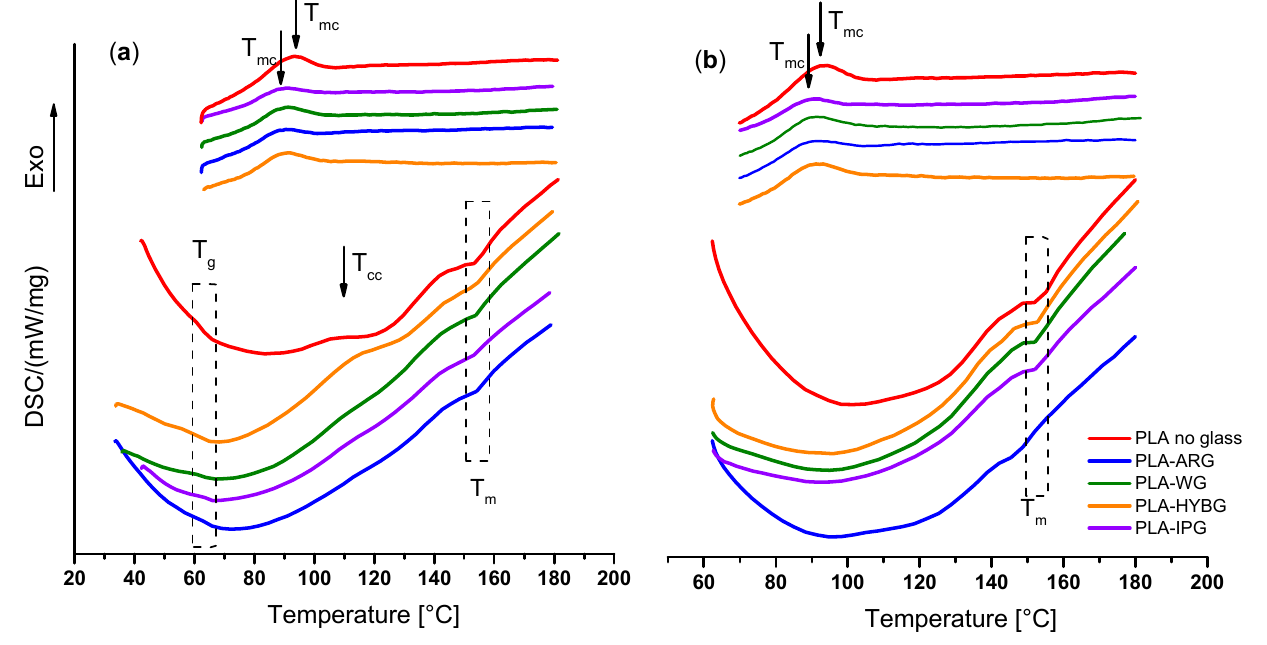
Figure 4. DSC curves for the neat PLA and PLA–glass composites in ( a ) first and ( b ) second heating- cooling cycle.